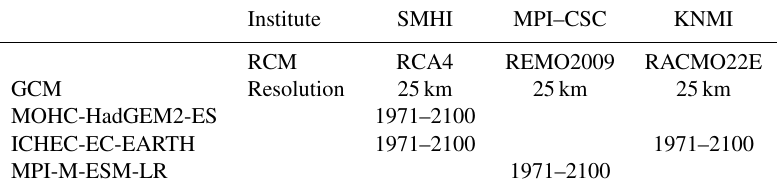
Table A4. Bias-corrected CORDEX-EUR-11 simulations for RCP4.5 and RCP8.5 used in the study (Wilcke et al., 2013; Gobiet et al.,